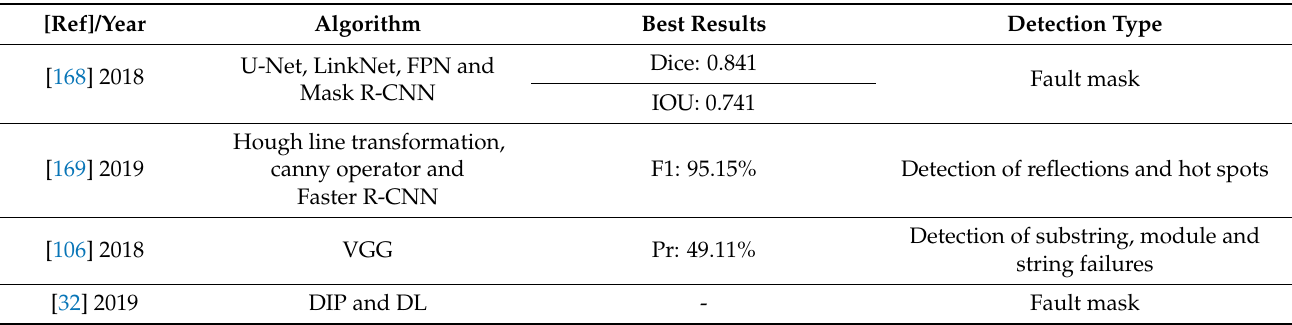
Table 7. Summary of methods for detecting PV modules in aIRT using DL and classification